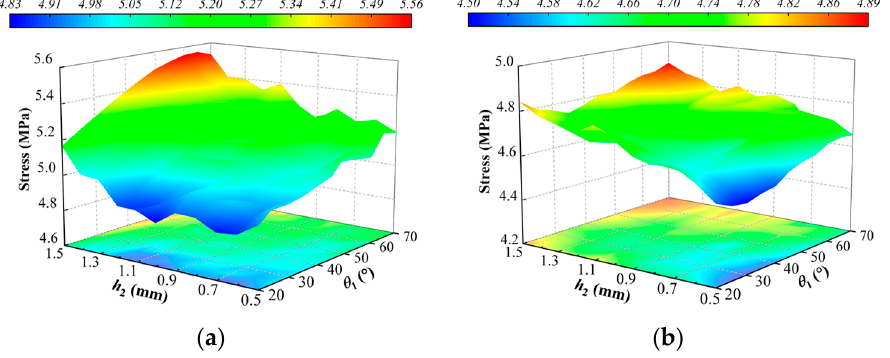
Figure 5. The tangential stress of PM. ( a ) SIPM1. ( b ) SIPM2.